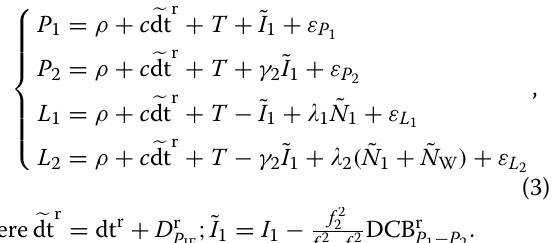
N 2 N 1 is the floating wide- pseudo-range; and ˜ N W = ˜ − ˜ lane (WL) ambiguity (cycles) containing the biases of both the carrier phase and the pseudo-range. If known satellite clock corrections and DCBs are used to correct the observation equations of the UCPPP model, the corresponding simplified formulae